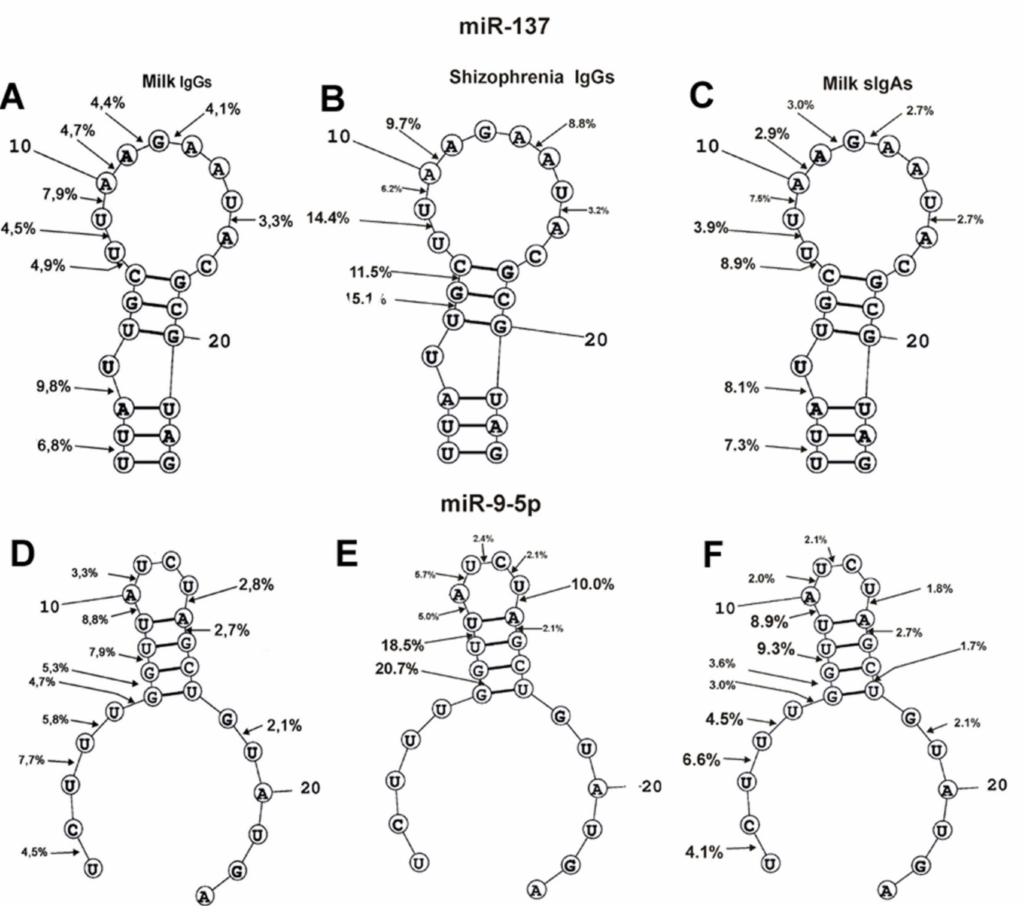
Figure 5. The average e ffi ciency of F-miR-137 ( A–C ) and F-9-5p ( D–F ) by seven milk IgGs ( A , D ), IgGs of SCZ patients ( B , E ), and seven milk sIgAs ( C , F ) in all sites of their cleavage. The average percentage of two miRNA cleavages in di ff erent sites and the positions of major and moderate sites of miRNAs hydrolysis by all Abs are shown in the panels. For comparison, the data on the hydrolysis of miRNAs by milk sIgA [63] and the IgGs of schizophrenia patients [63,64] are taken from previously published